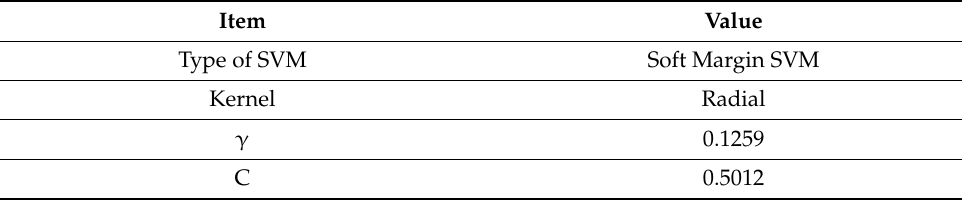
Table 1. Parameters of